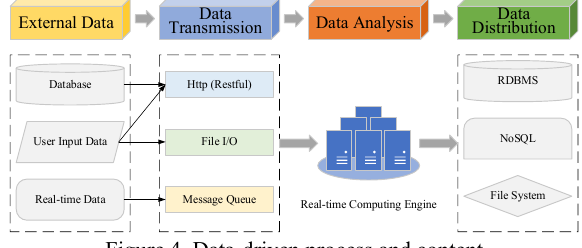
Figure 4. Data-driven process and content